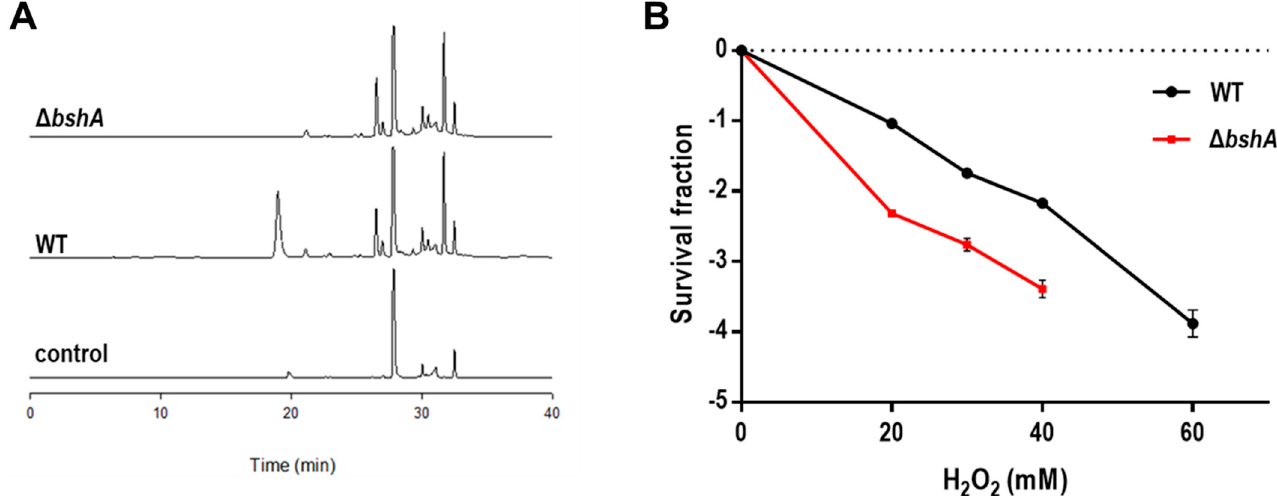
Figure 2. Characterization of D. radiodurans bshA mutant strain ( ∆ bshA ). ( A ) Representative HPLC analysis of BSH in the D. radiodurans wild-type strain (WT) and ∆ bshA . BSH was derivatized with monochlorobimane (mBCl) and analyzed by HPLC. Cell extraction buffer was used as control. The HPLC analysis of cellular thiols was repeated two times, with no significant difference in the results. ( B ) Survival of ∆ bshA exposed to H 2 O 2 . WT and ∆ bshA were treated with H 2 O 2 at the indicated concentrations for 1 h. The survival fraction was calculated by dividing the colony forming units (CFU) of H 2 O 2 treated cells by the CFU of non-treated cells. Values are means and standard deviations of two independent experiments conducted in duplicate.